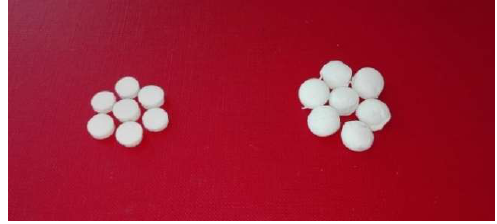
Figure 2. Pectin aerogels and chitosan-coated pectin aerogels.